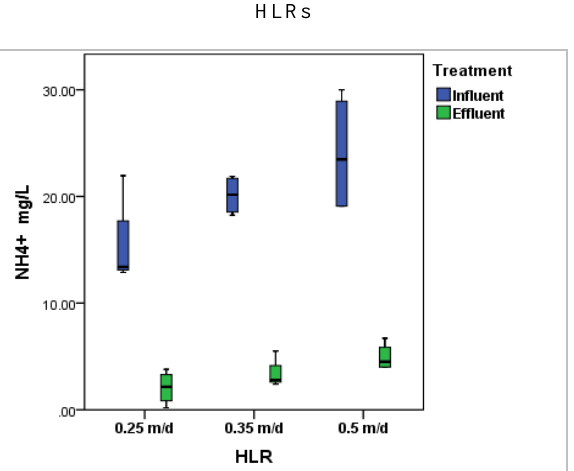
Table 6. Removal performance of nutrients under different